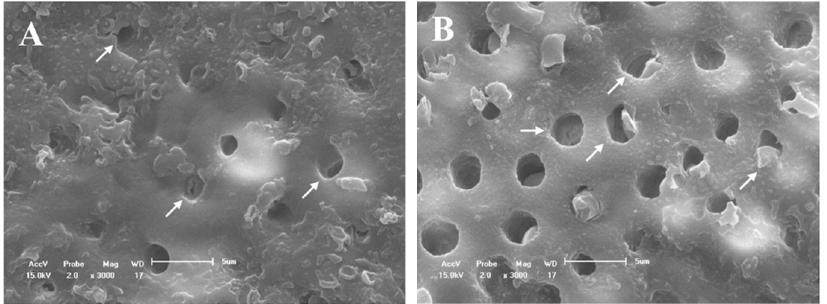
Figure 6. SEM micrographs of the dentine surface morphology at 3000× magnification. ( A ) Fluoride varnish with nanofiber and ( B ) after 6% citric acid challenge. The arrows indicated the regions with crystals adhered to the dentinal tubules ( A , B ).